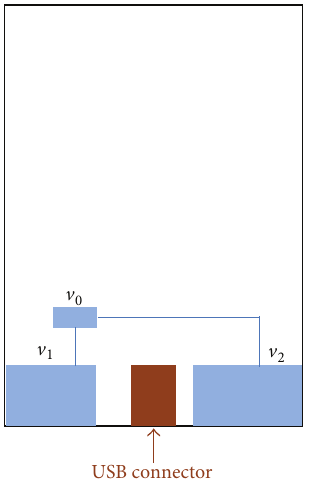
Figure 1: Geometry of the proposed antenna of the mobile phone for multibands operation.